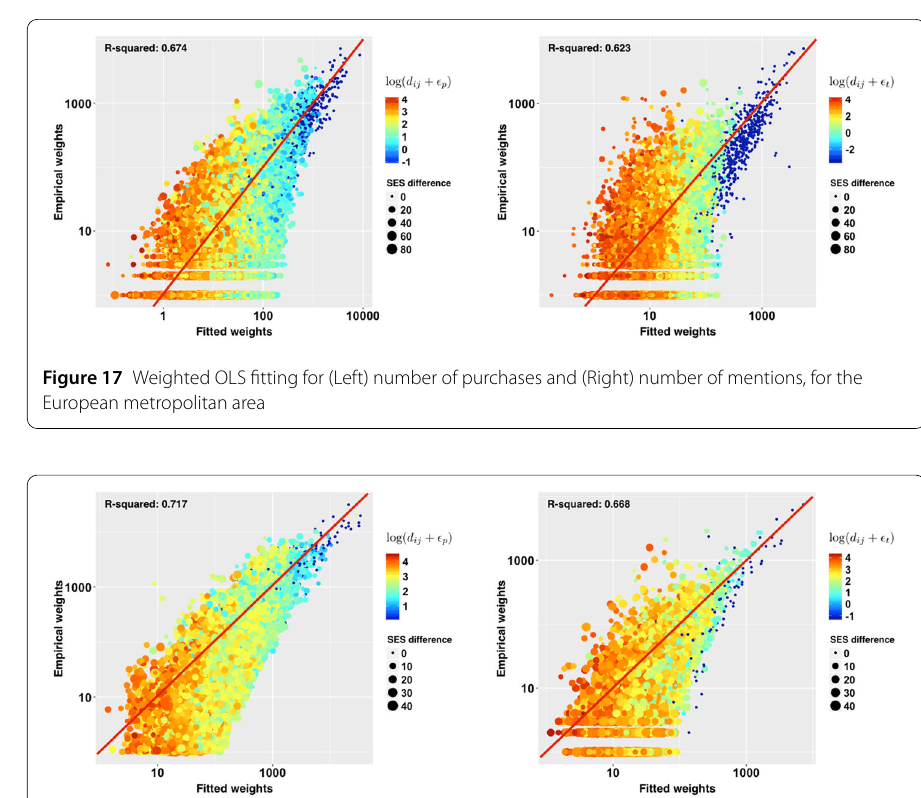
Figure 18 Weighted OLS fitting for (Left) number of purchases and (Right) number of mentions, for the Latin American metropolitan area